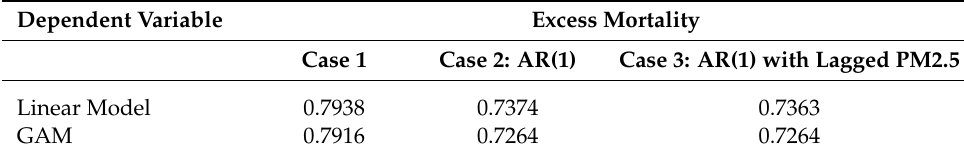
Table 2. Excess Mortality ( t ) RMSE comparison between LM and GAM.